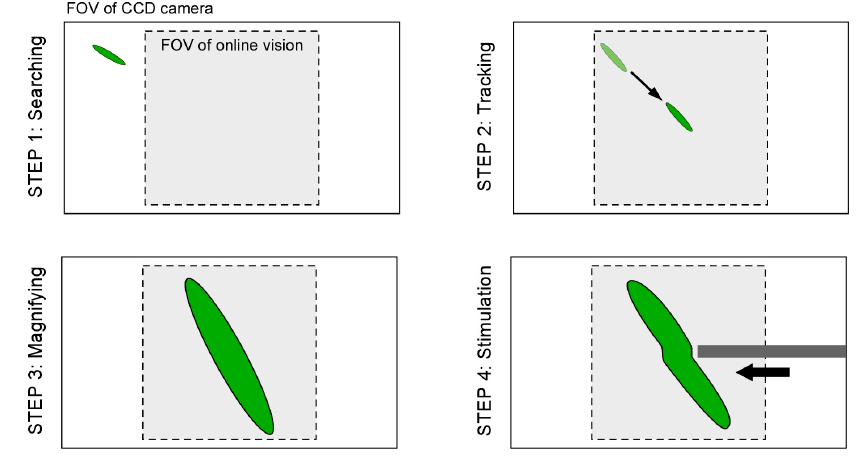
Figure 4. Four-step procedure to realize investigation of single motile microorganism.